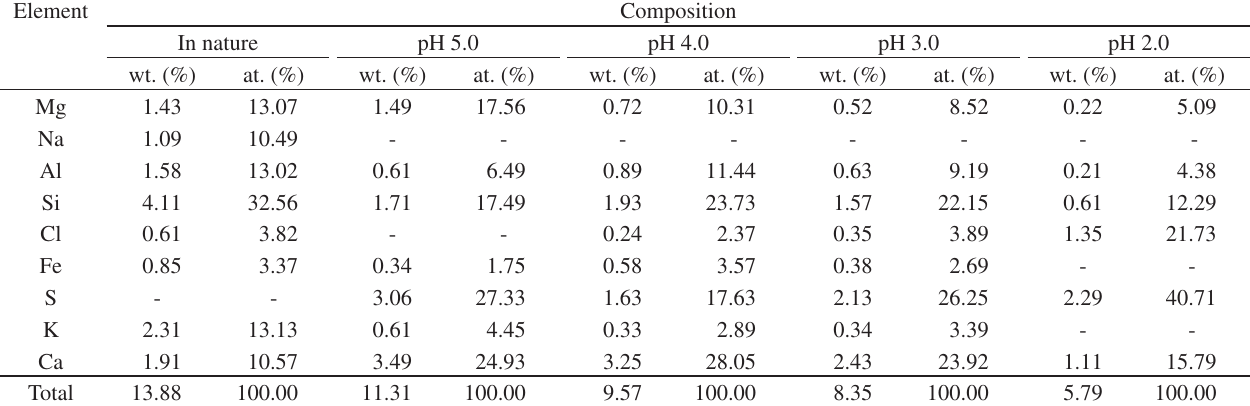
Table 6. Elemental composition of Sargassum filipendula treated in the different pHs. Element Composition